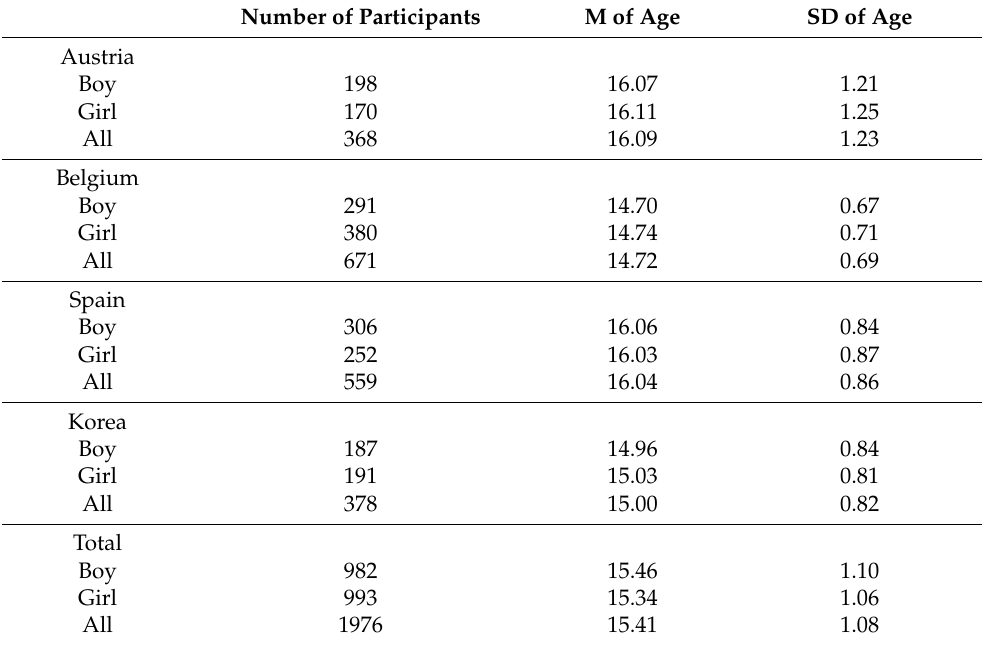
Table 1. Description of the